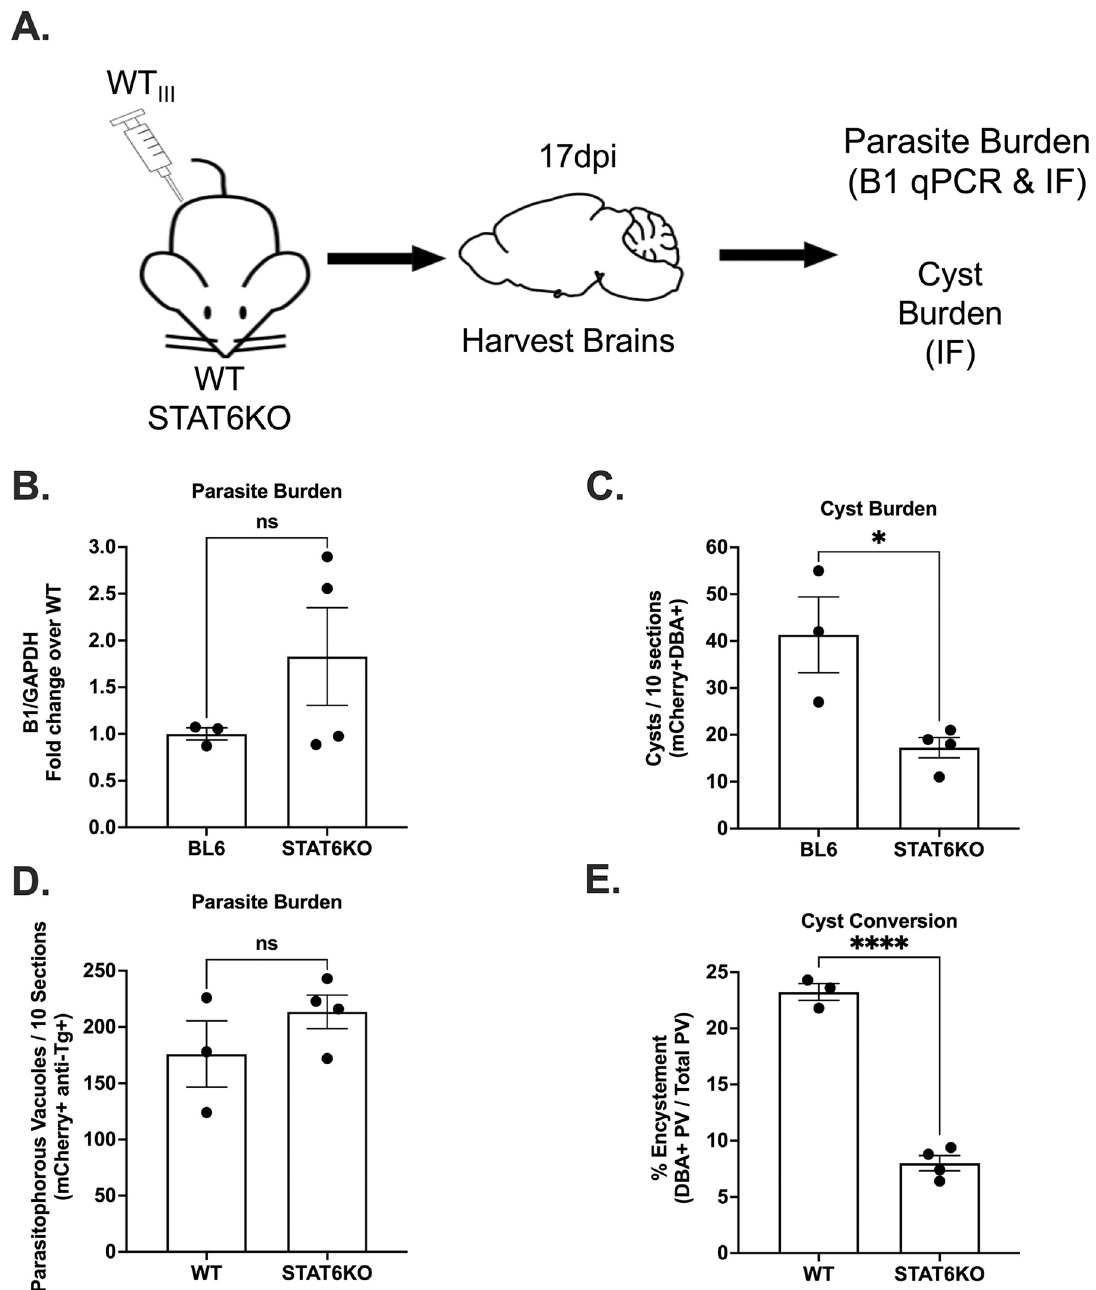
Fig 5. STAT6KO mice have lower CNS cyst burdens, but not overall CNS parasite burden, at 17 dpi. (A) Schematic of mouse infection for STAT6KO mice. (B) Quantification of T . gondii gene B1 was done using qPCR. Bars, mean ± SEM. Black dots = 1 mouse. N = 3–4 mice per condition. (C) Quantification of cyst burden (mCherry + DBA + ). Total number of cysts per 10 sections per mouse. (D) Quantification of the parasitophorous vacuole (PVs) burden. Total number of PVs per 10 sections per mouse. (E) Quantification of the percentage of total PVs that were also DBA + . (B-E) Bars, mean ± SEM. Black dots = 1 mouse. N = 3–4 mice per condition. * p � 0.05., p **** � 0.0001, ns = not significant, one-way ANOVA, Dunnett’s multiple comparisons test compared to